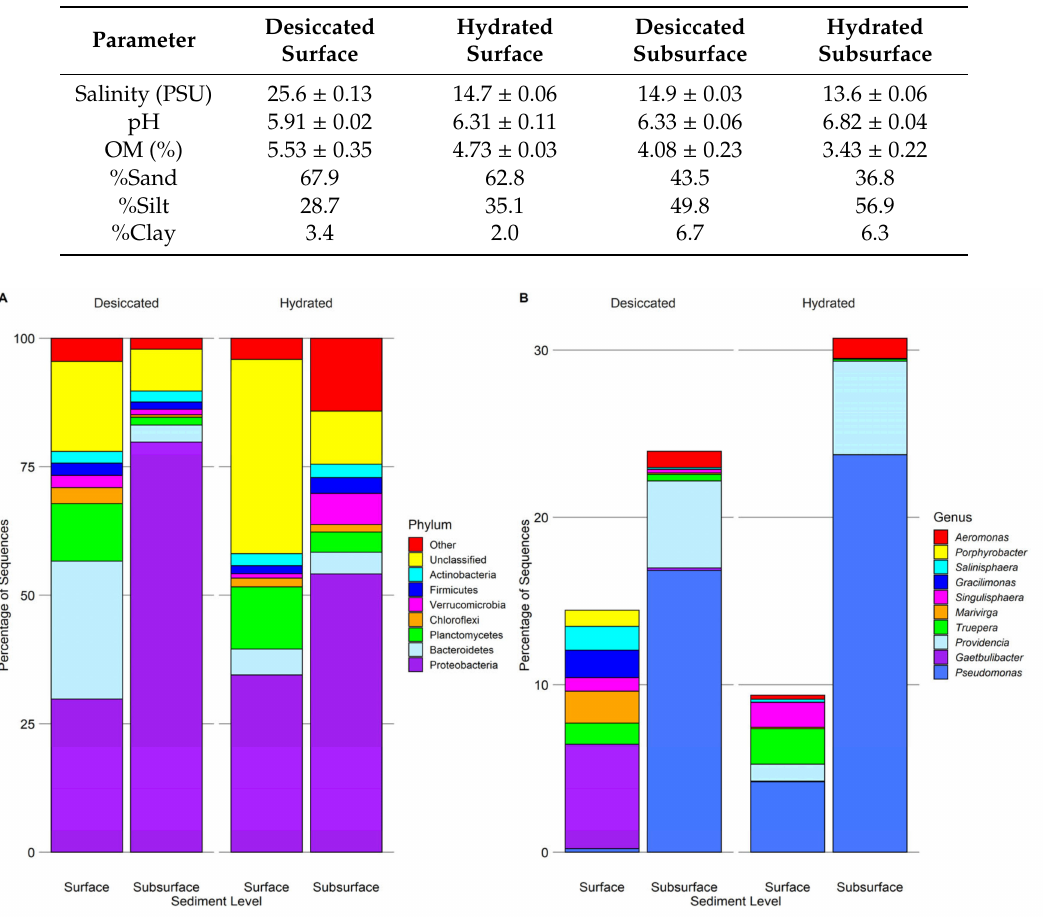
Table 1. Sediment physico-chemical characteristics of a saltpan wetland along the Mississippi Gulf Coast. Salinity (PSU) and pH were calculated by hydrating sediment in a 1:5 dilution in the lab and measured using a YSI probe and pH electrode. Percent organic matter (OM%) was calculated by loss on ignition. Sand silt and clay fractions were calculated by sieving the 1:5 dilution through a 0.053 mm mesh (sand) and separating silt from clay by settling for 4 h. The dry weight of each fraction was divided by the original dry sample mass to derive the percentage composition of each. Salinity, pH, and OM% were performed in triplicate, while particle sizes were determined from a pooling of the triplicates.